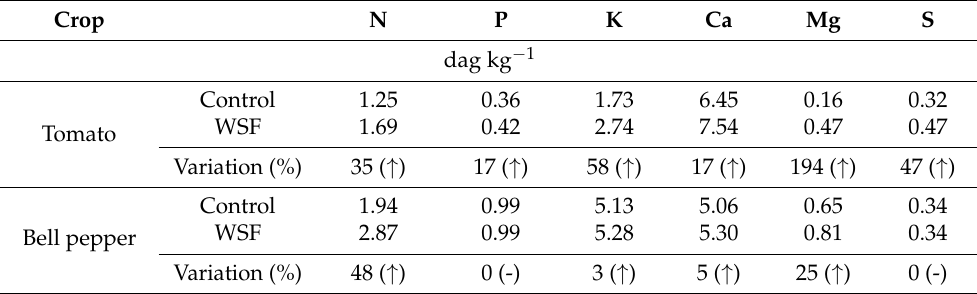
Table 2. Content of macronutrients in infested-RKN tomato and bell pepper tissues treated with different water-soluble fractions (WSF) extracted from vermicomposts. Upwards pointing arrows indicate an increase and downwards pointing arrows indicate a